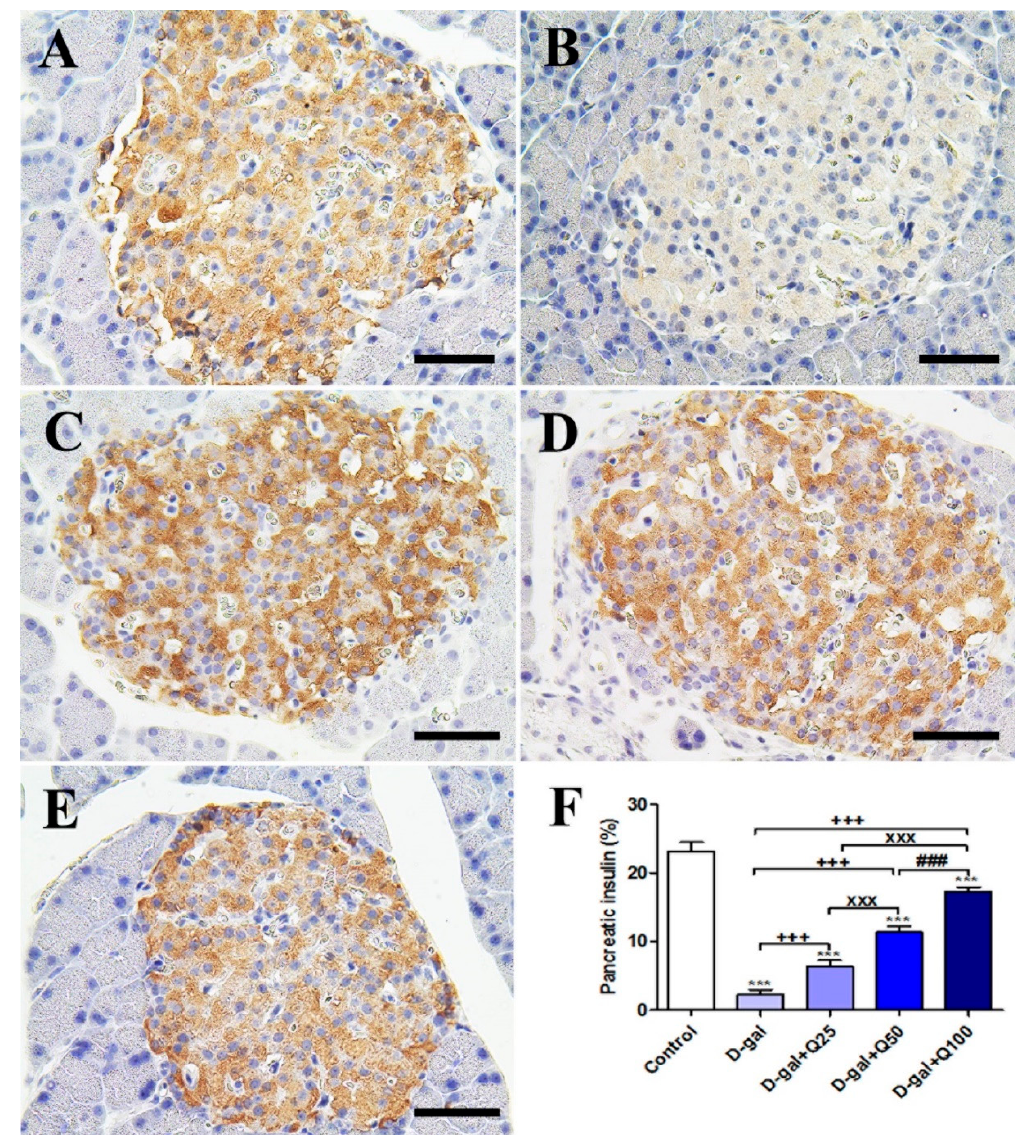
Figure 4. Immunohistochemical staining of rats’ pancreas with insulin. ( A ) Negative control group. ( B ) D-gal group. ( C ) D-gal + Q25 group. ( D ) D-gal + Q50 group. ( E ) D-gal + Q100 group. ( F ) Quantification of insulin in pancreatic islets of Langerhans in different groups. Scale bar = 50 µm . Data were analyzed with one-way ANOVA followed by Tukey’s multiple comparison test. *** p < 0.001 vs. control. +++ p < 0.001 vs. D-gal. xxx p < 0.001 vs. D-gal + Q25. ### p < 0.001 vs. D-gal + Q50. Error bars represent mean ± SD.